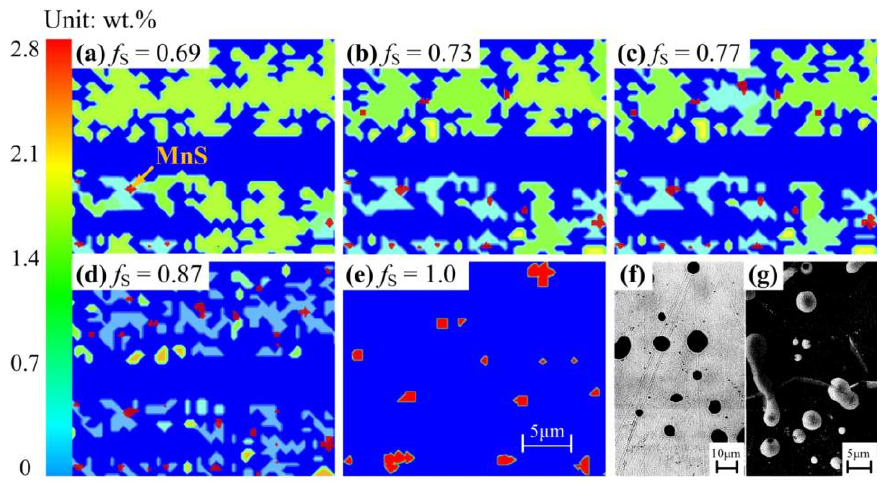
Figure 6. MnS precipitation in Part A and its comparison with experimental observations. Metals 2018 , 8 , x FOR PEER REVIEW